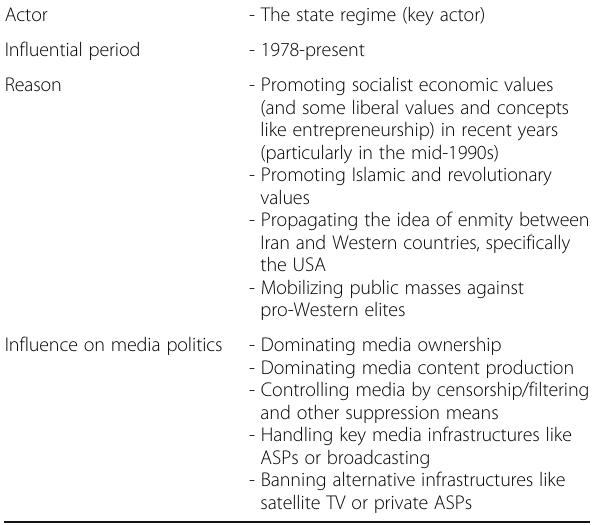
Table 2 The key actor in the relationship between media and